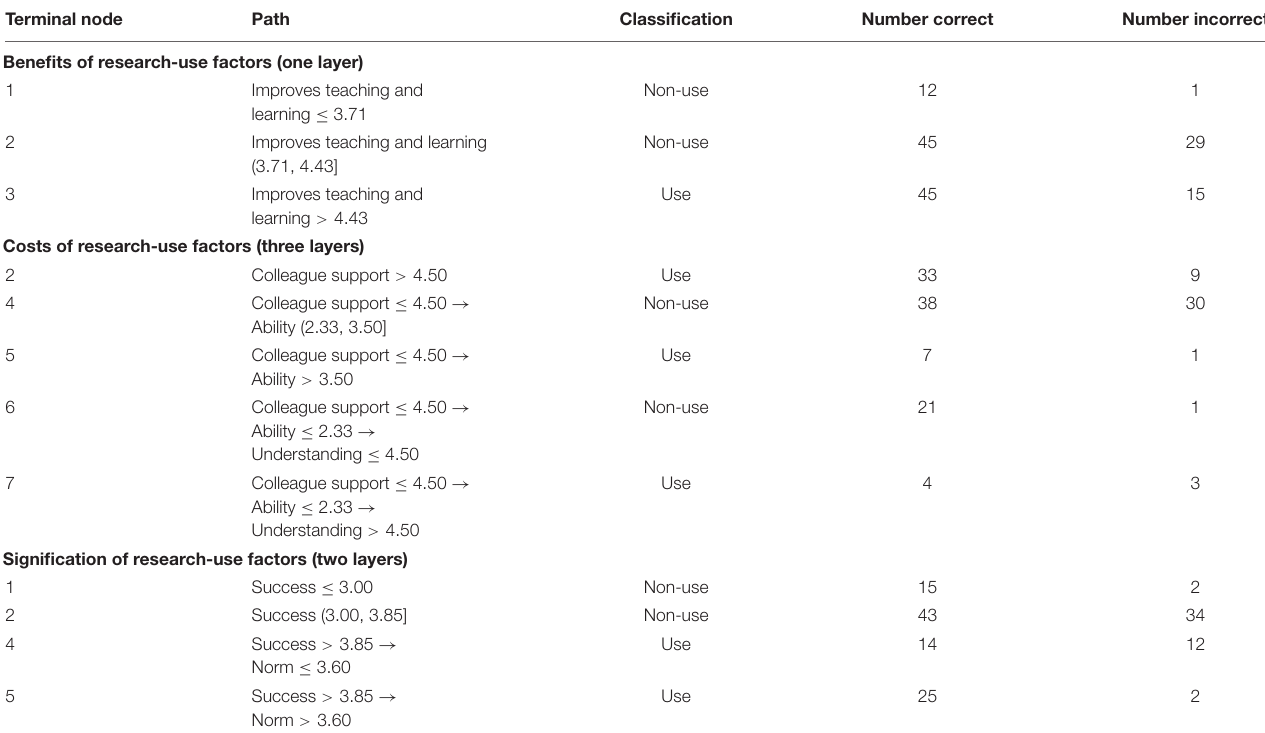
TABLE 7 | Summary of case classification at terminal